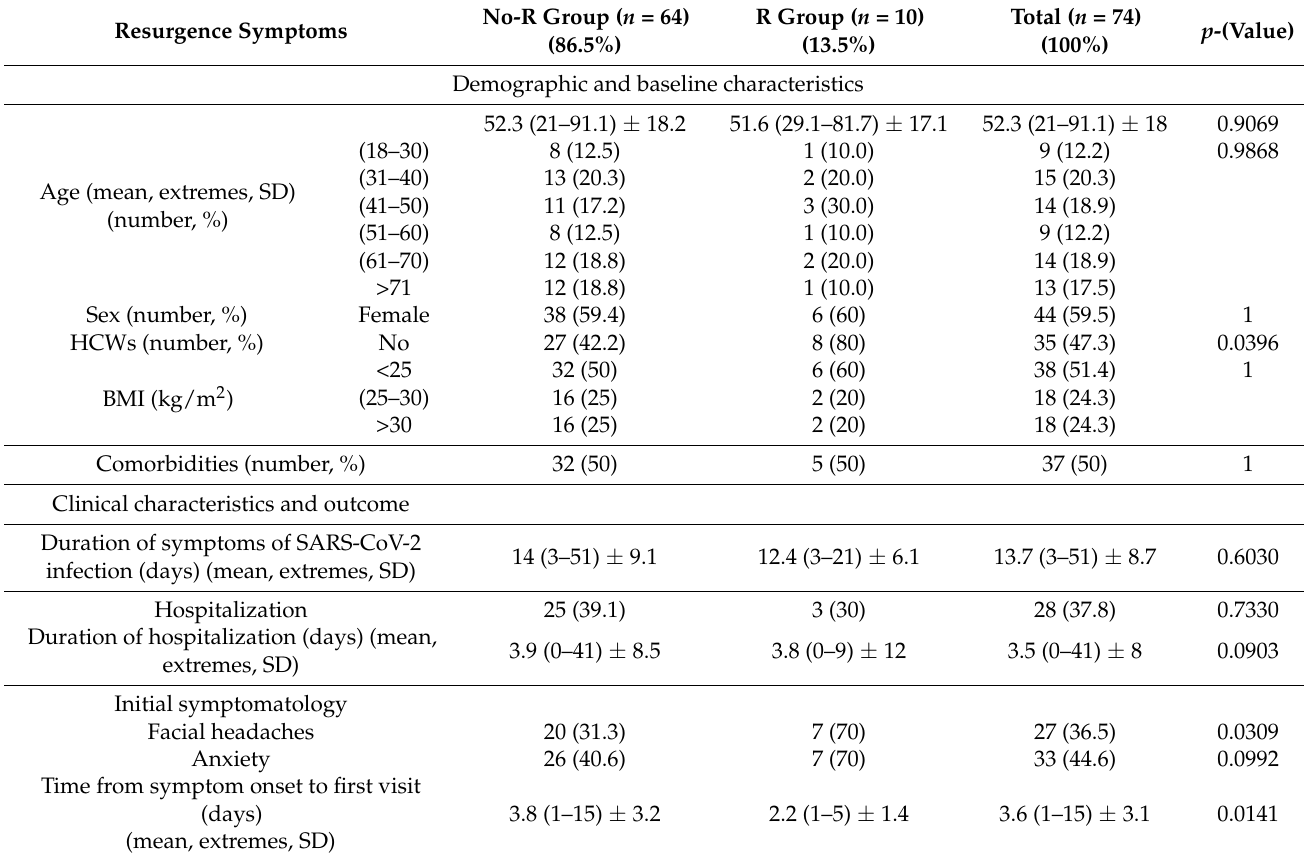
Table 3. Demographic and clinical characteristics in 74 COVID-19 patients with or without resurgence symptoms after SARS-CoV-2 infection, Nord Franche-Comte Hospital, France. Resurgence